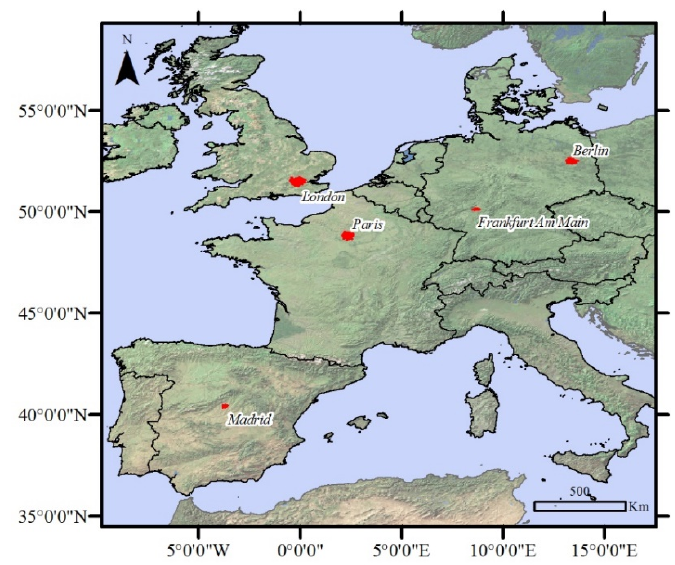
Figure 1. Location of study cases.